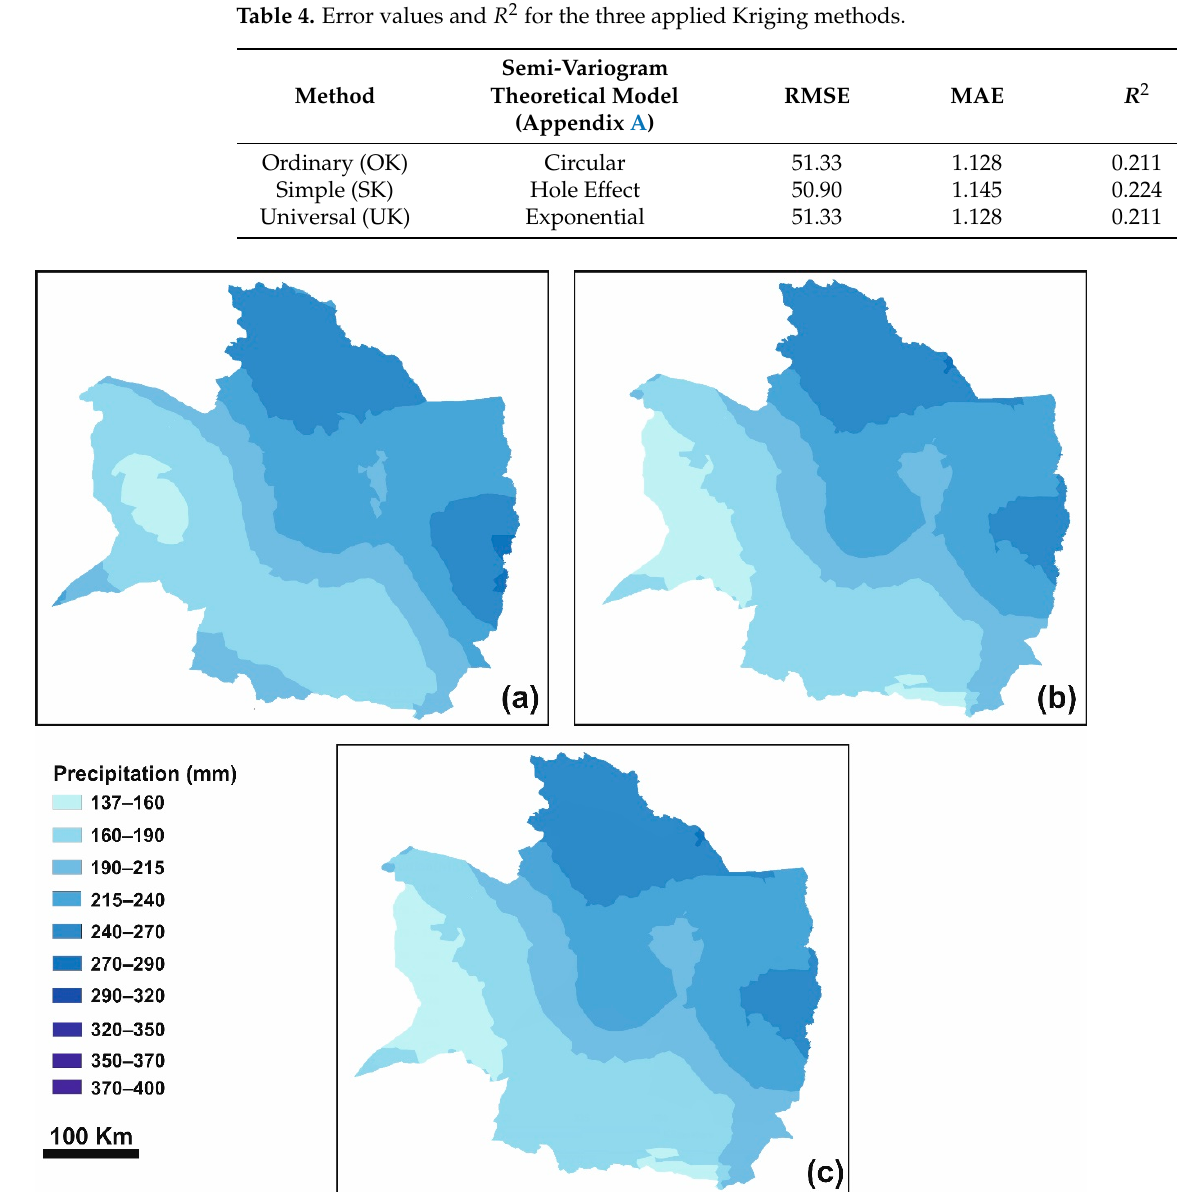
Figure 4. Interpolated annual precipitation maps based on the three Kriging methods: ( a ) Simple, ( b ) Ordinary, ( c ) Universal.